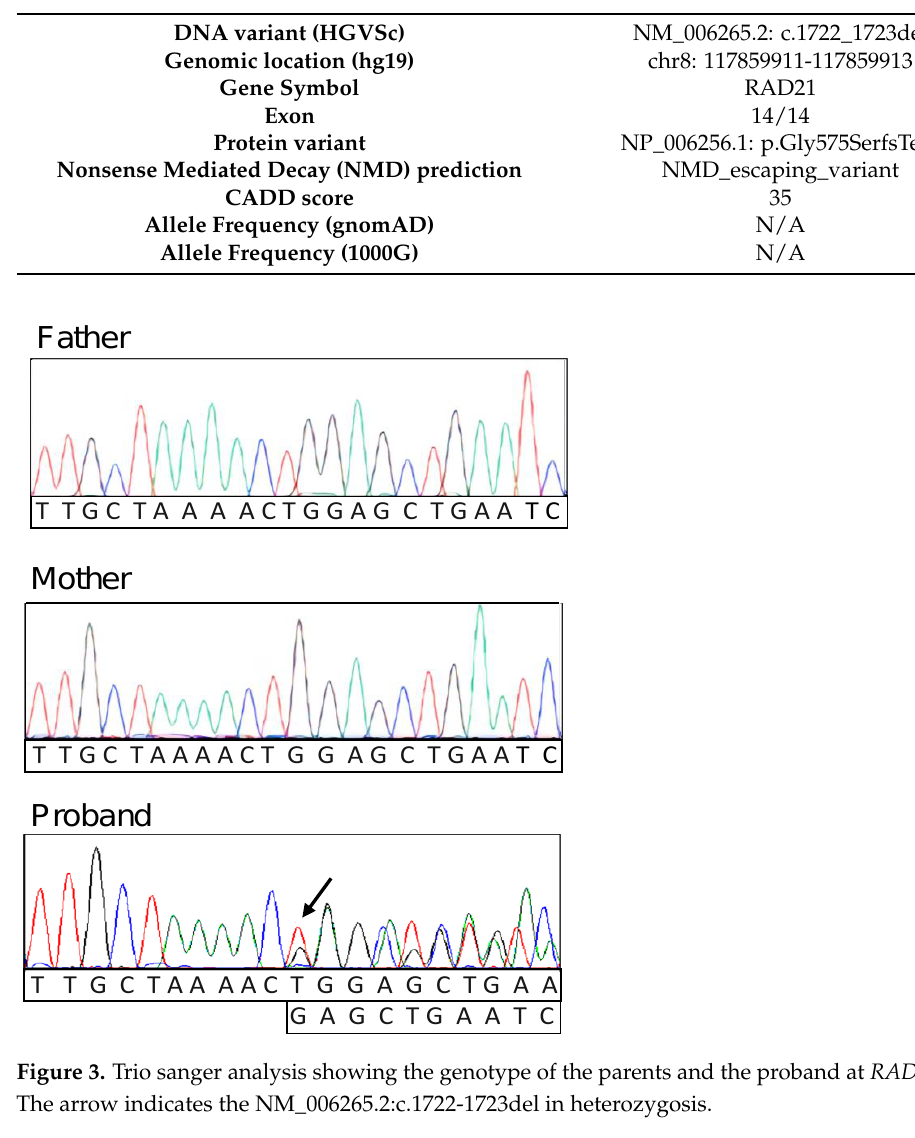
Table 2. Annotation features of NM_006265.2: c.1722_1723del variants.